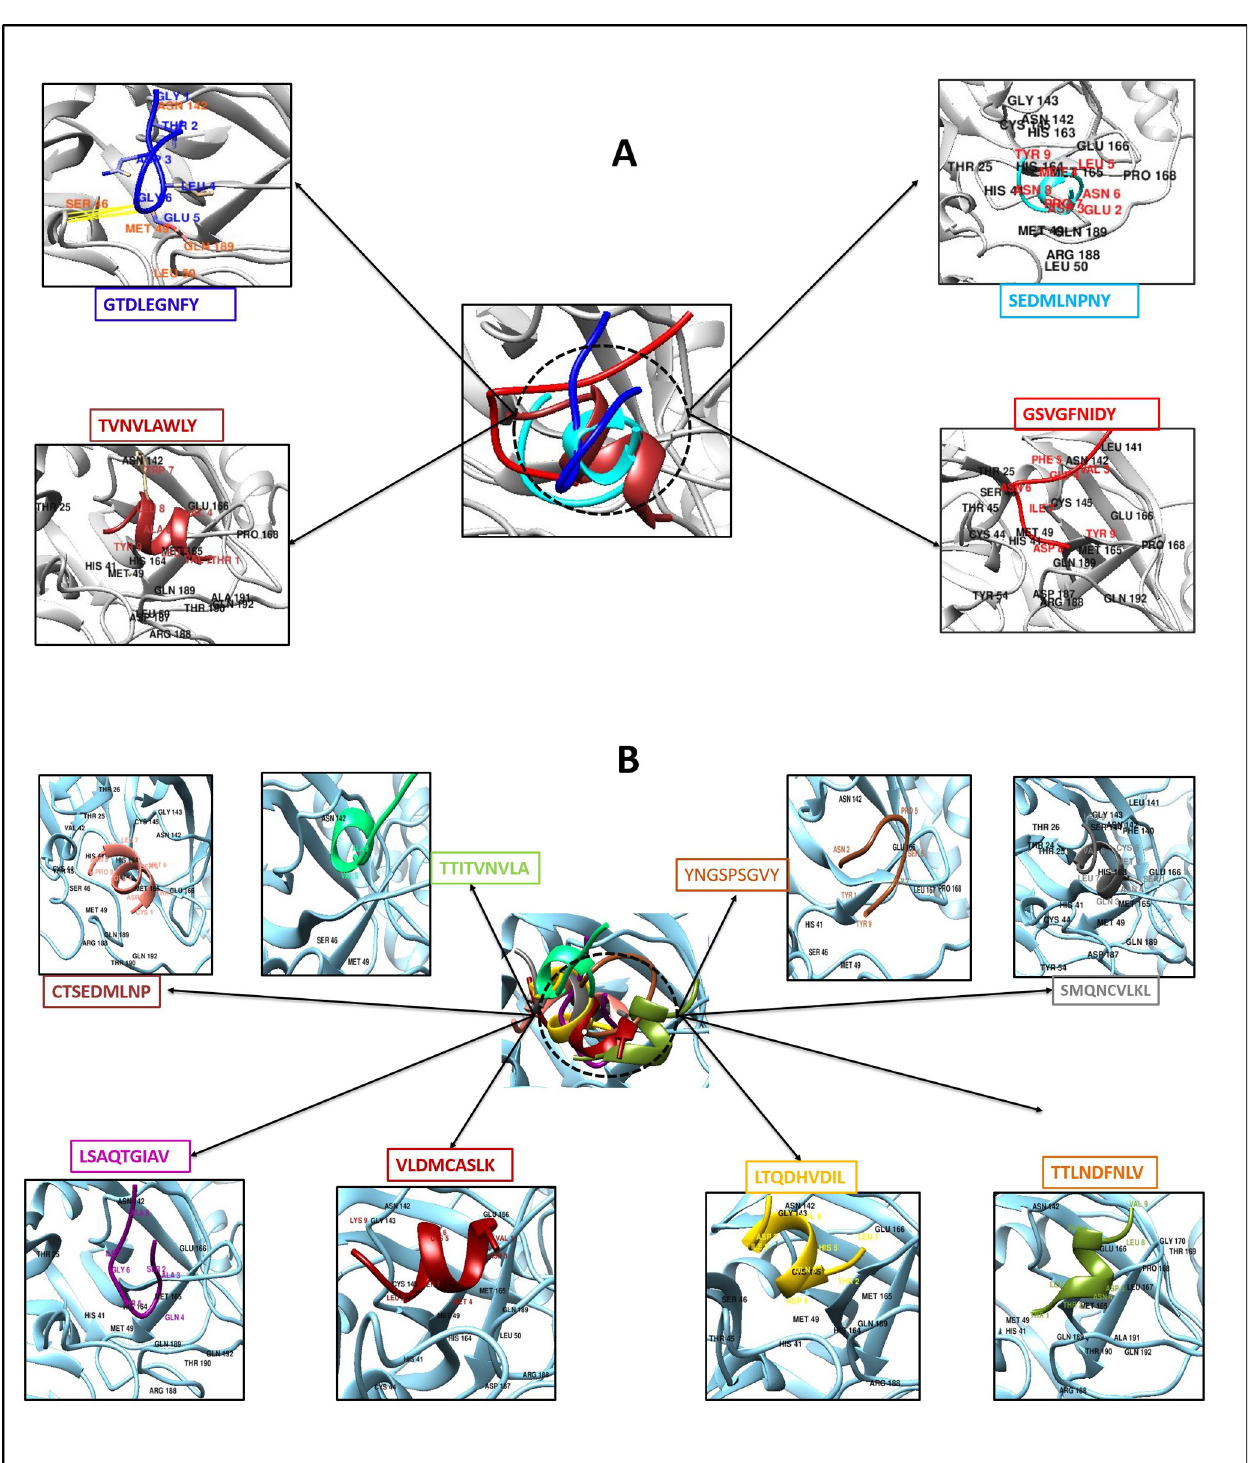
Fig 3. A: Peptide-MHC class I HLA-B binding interacting residues of four top-ranked peptides and their sequences presented in different colors. A: Peptide- MHC class I HLA-B binding interacting residues of eight top-ranked peptides and their sequences presented in different colors. Conserved residues are already shown in Table